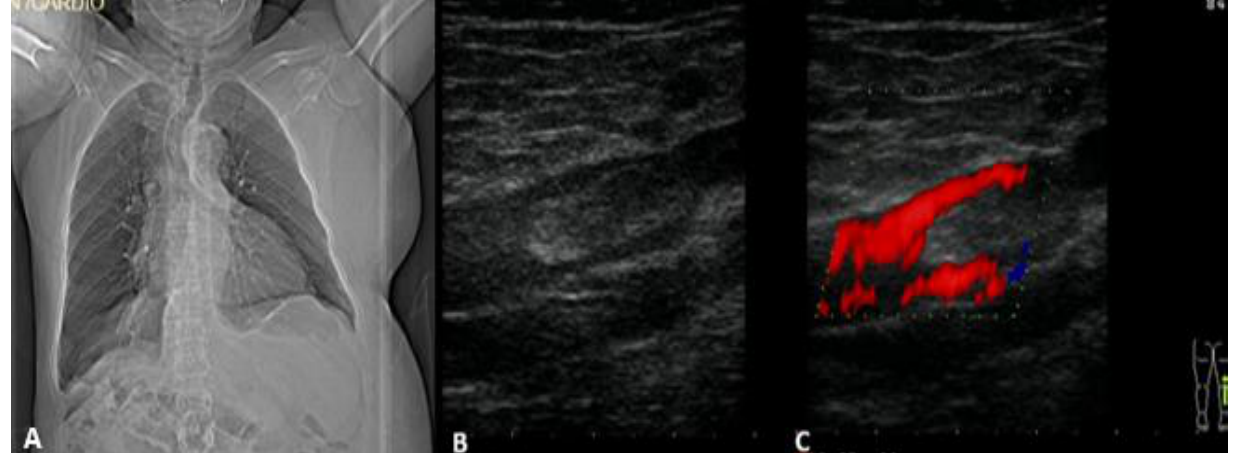
Figure 1. A - Chest computed-tomography evidencing abdominal situs inversus; B - Immage of a Figure 1. ( A ) Chest computed-tomography evidencing abdominal situs inversus; ( B ) Immage of a thrombus in the vein; C—venous Doppler exam evidencing a thrombus in thevein. thrombus in the vein; ( C ) venous Doppler exam evidencing a thrombus in